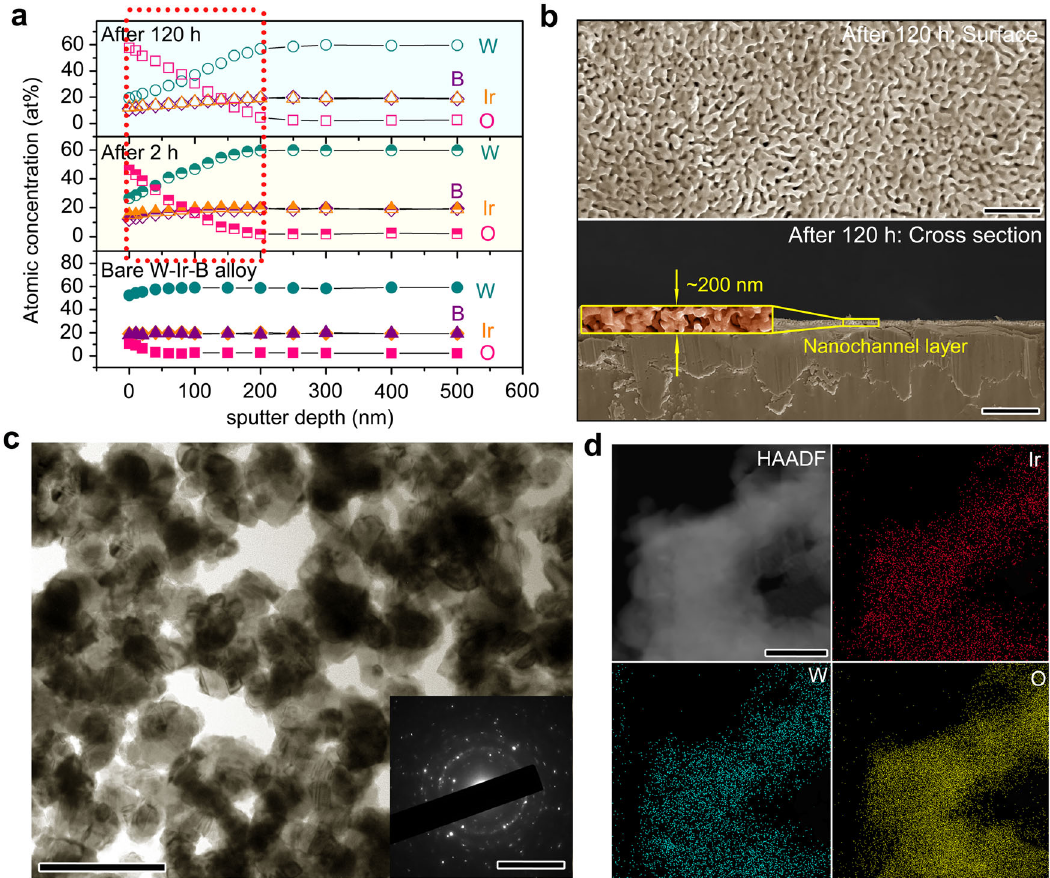
Fig. 3 Surface active structure formed during the acidic OER and the characterizations. a XPS sputter depth pro fi le measurements of the bare W-Ir-B alloy catalyst, the alloy catalyst after 2 h OER test, and the alloy catalyst after 120 h OER test. The red dotted box indicates the depth of the surface active thin layer. b Surface and cross-sectional SEM images of the W-Ir-B alloy catalyst after the 120 h acidic OER test. The inset shows the magni fi ed cross- section image of the nanochannel structure (yellow solid box). c TEM image of the surface active oxides formed during the 120 h acidic OER. The inset shows the SAED pattern. d STEM elemental mapping of the surface nanochannel structure. Scale bar: b 500 nm (top), 1 μ m (down); c 200 nm, 5 nm − 1 (inset); d 100